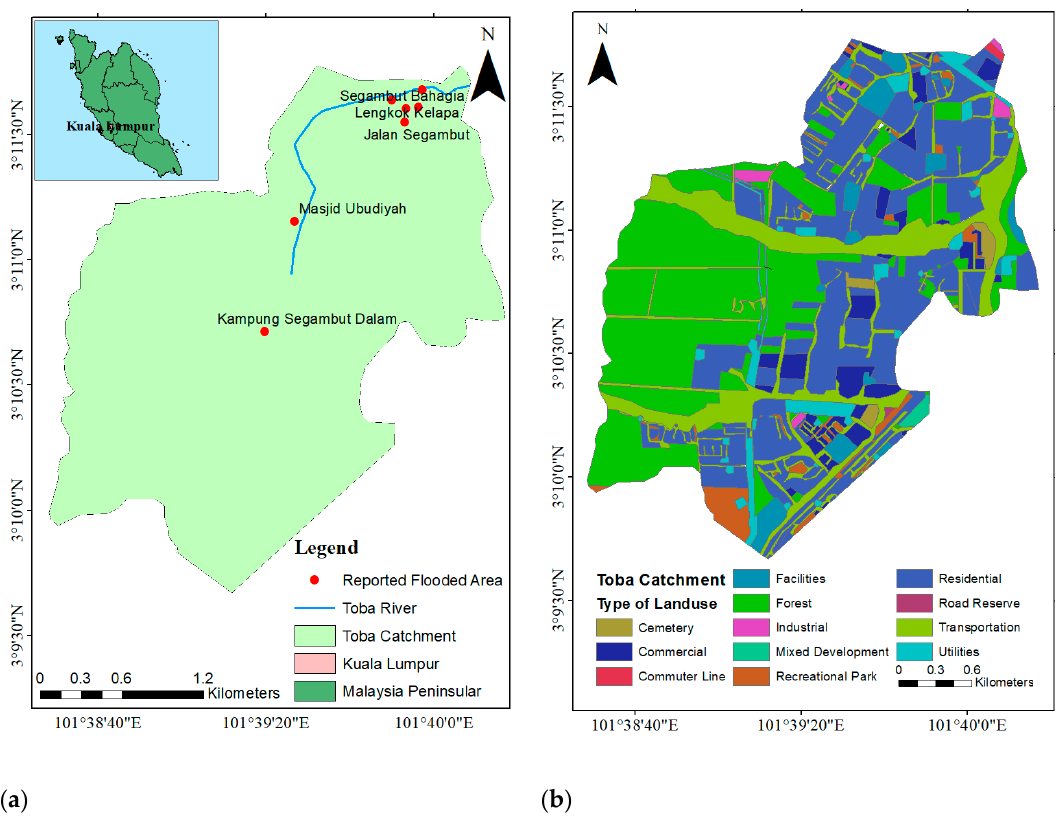
Figure 1. The Toba Catchment. ( a ) Reported flood locations with some locations having multiple occurrences, and ( b ) land use map. occurrences, and ( b ) land use